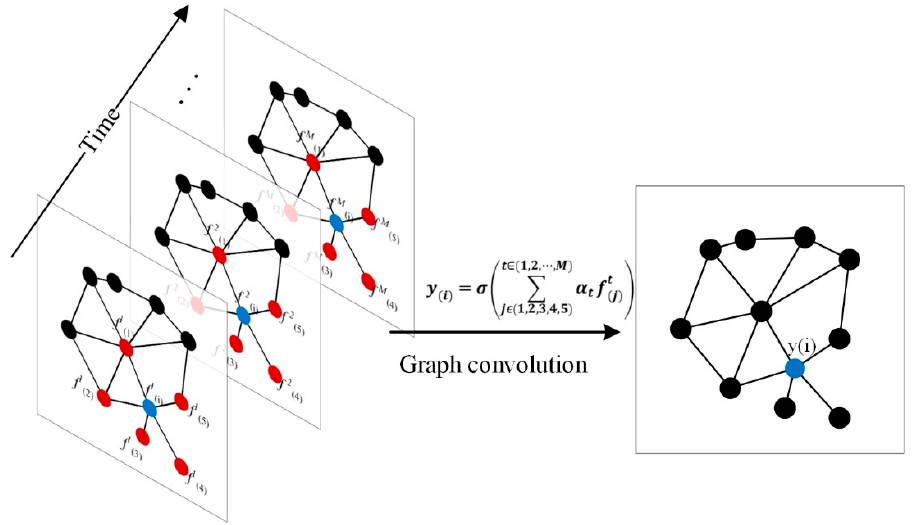
Figure 3. Procedure for capturing spatiotemporal dependencies by graph convolution for K = 1 (using only one vertex as an example). α t is the convolution kernel parameter at the time step t , and f t indicates the historical passenger flow volume of vertex j at the time step t .